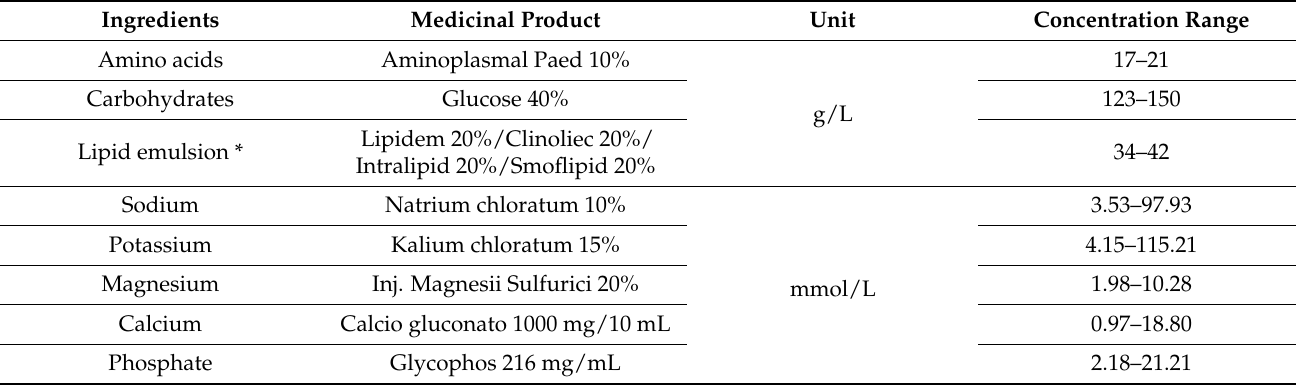
Table 1. The concentration range of ingredients of PN admixtures.